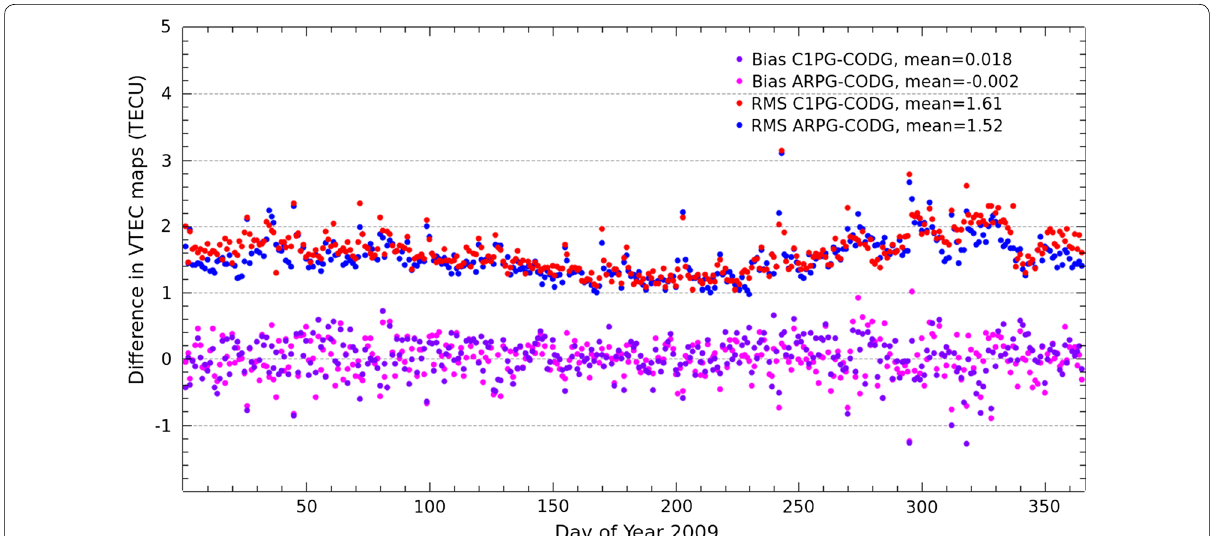
Fig. 3 Statistics of the differences in forecasting VTEC values (C1PG and ARPG) and final CODE VTEC values in 2009. The bias and RMS values of the differences are indicated by dots of different colors